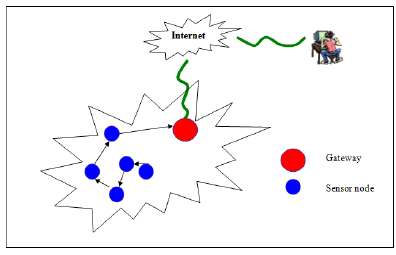
Figure 1. Sensor nodesin